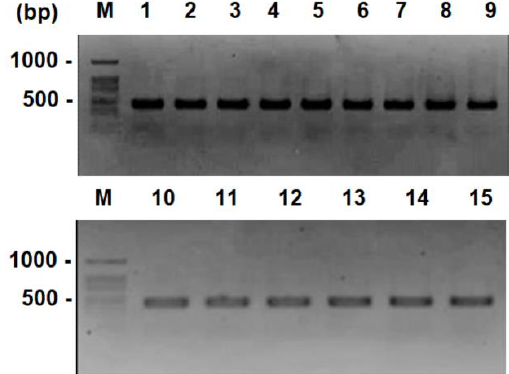
Figure 1. Amplification of the ITS1-5.8S-ITS2 segment from the DNA of Brettanomyces bruxellensis isolated from winemaking regions in Chile. Strains: L-2472 (lane 1), L-2474 (lane 2), L-2476 (lane 3), L-2480 (lane 4), L-2482 (lane 5), L-2570 (lane 6), L-2597 (lane 7), L-2676 (lane 8), L-2679 (lane 9), L-2690 (lane 10), L-2731 (lane 11), L-2742 (lane 12), L-2755 (lane 13), L-2759 (lane 14) and L-2763 (lane 15). 100 bp molecular weight was used (lanes M).